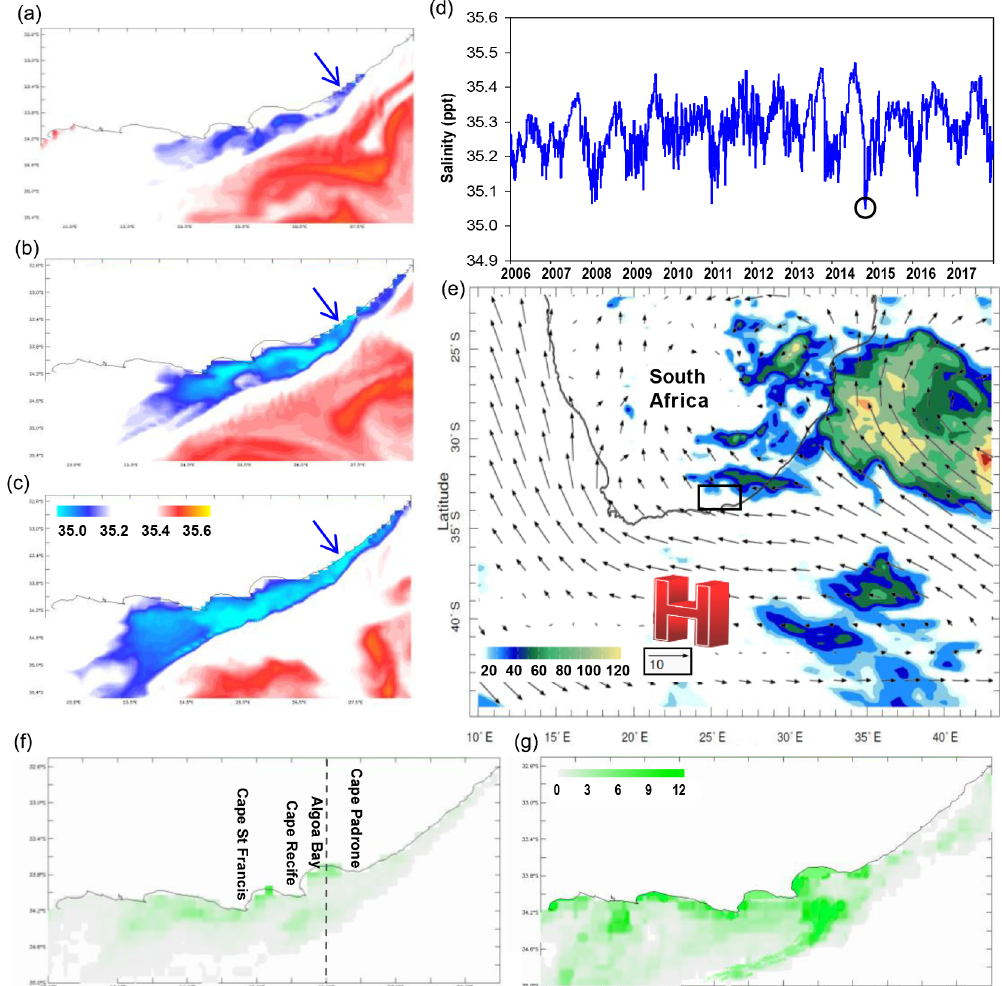
Figure 4. Salinity maps (a) 15–20 October, (b) 20–25 October, and (c) 25–30 October 2014 when the cumulative Great Fish River discharge exceeded 1010m 3 . (d) Daily record of index-area 10m salinity, with case study circled. (e) Large-scale 15–25 October 2014 cumulative CMORPH rainfall (shaded, mm) and low-level winds (vector). MODIS chlorophyll: (f) 8–23 October and (g) 24 October–8 November 2014. Arrow in (a) – (c) is the Great Fish River mouth. Dashed line in (f) is the section in Fig.